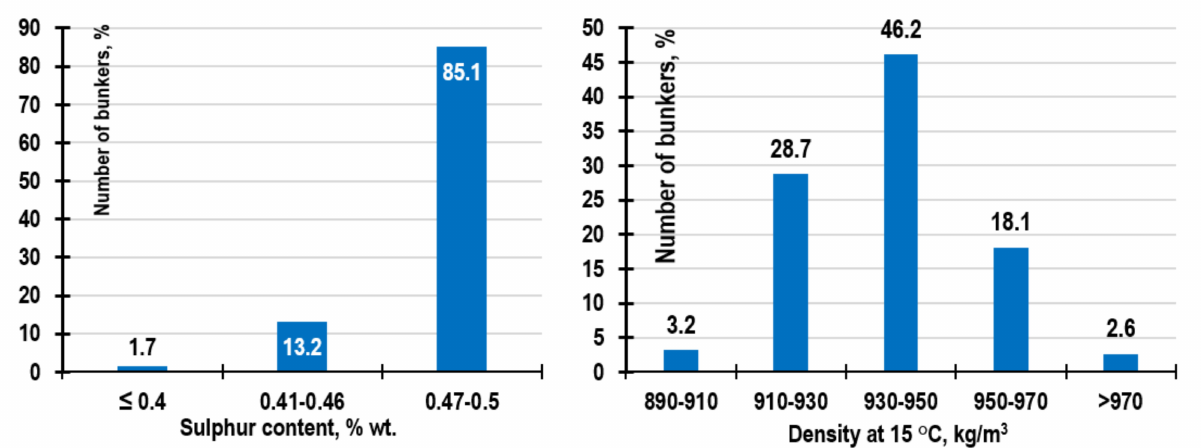
Figure 1. Sulphur content and density of VLSFO bunkered in world ports [43].